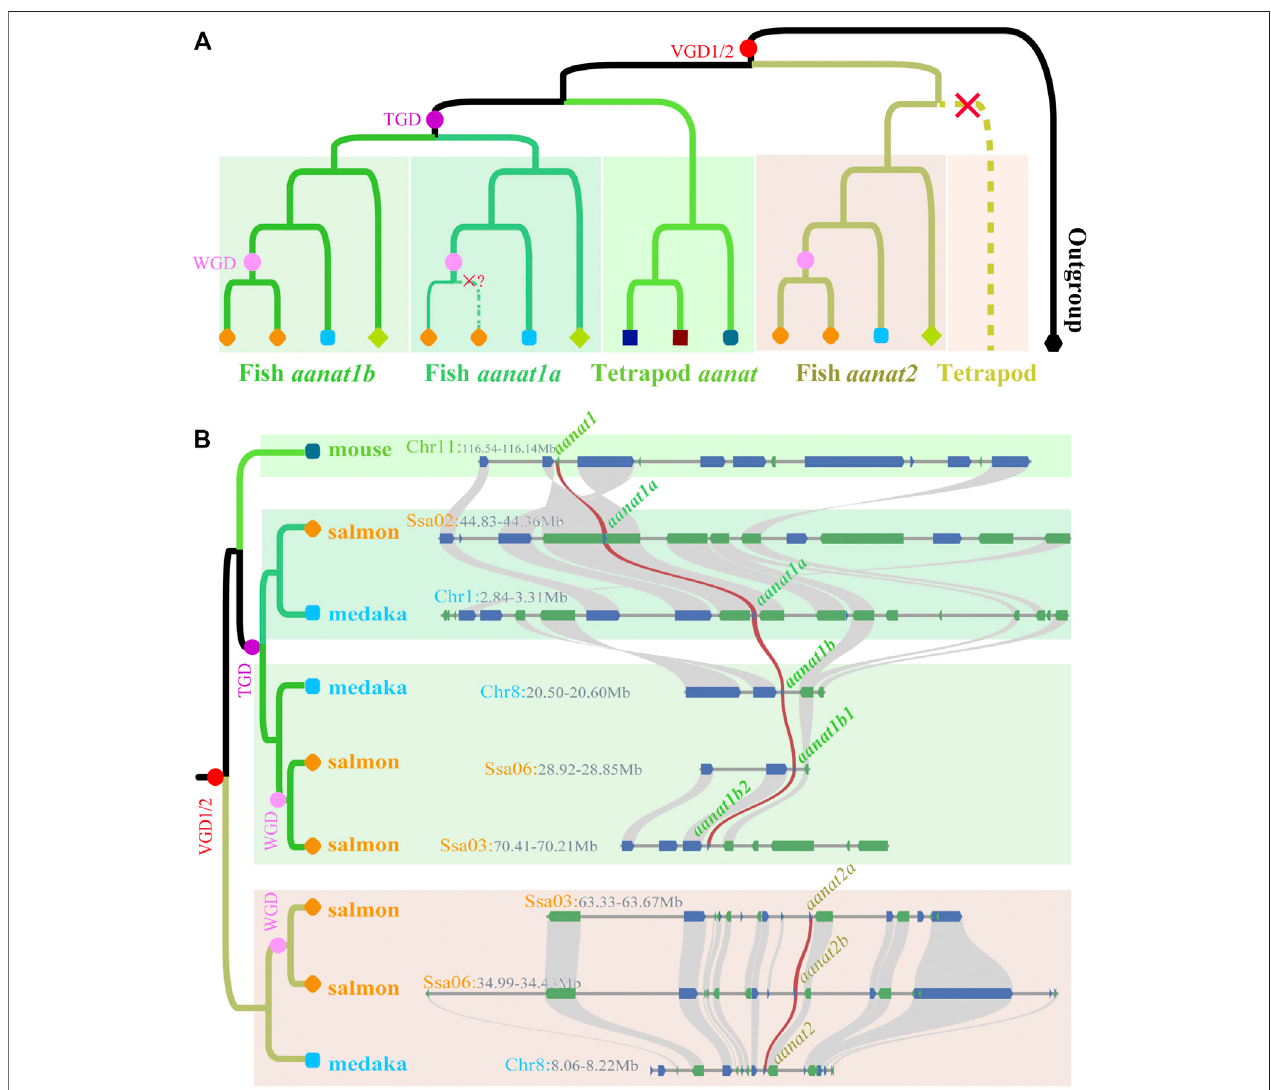
FIGURE2| Phylogeneticsof fi sh aanat genes. (A) Thephylogeneticmodelof aanats . aanat genesfromthesamespeciesaremarkedasthesamecolorandshape. Red, purple, and pink dots represent vertebrate, teleost-speci fi c, and lineage-speci fi c genome duplication events, respectively. Red crosses mark the loss of aanat in correspondingclades. (B) Syntenic relationshipamong aanats inrepresentativespecies.Twentygenesatthe up-stream and down-stream around aanats werechosen to establish the syntenic relationship. Blue (+) and green (-) boxes represent genes with different coding directions, and the brown synteny blocks along various species indicate the aanat